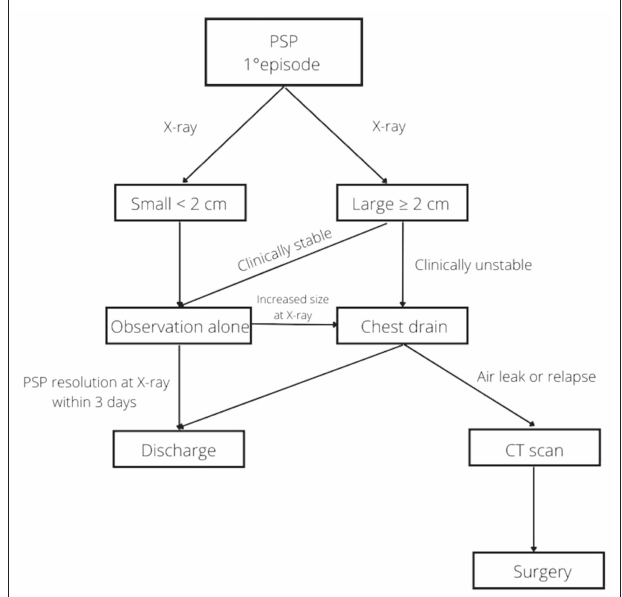
FIGURE 1 | Flow chart for management of pediatric patients with primary spontaneous pneumothorax at our